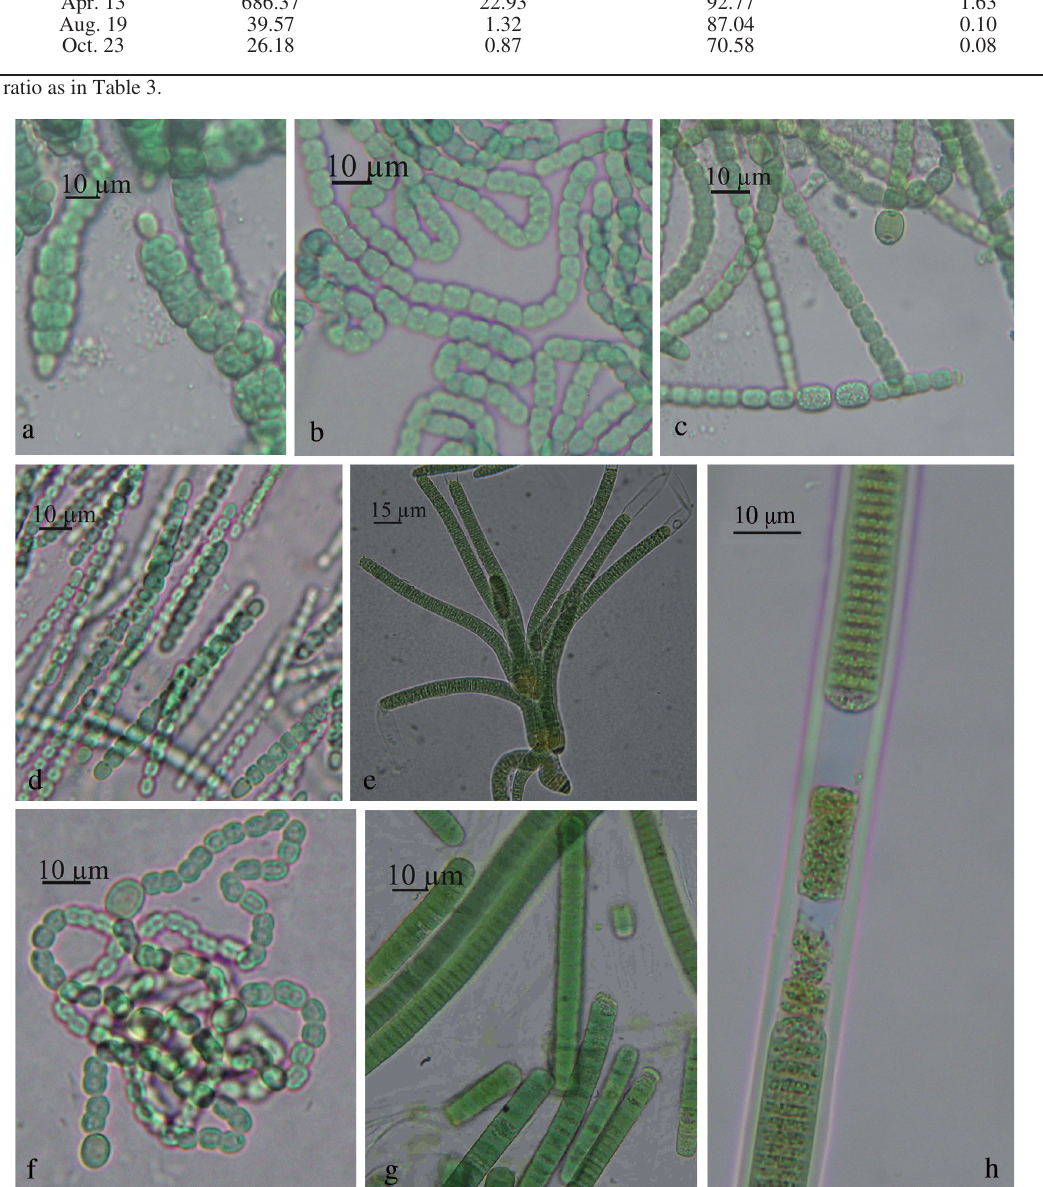
Fig . 4. – Photomicrographs of the main benthic nitrogen-fixing cyanobacteria detected in intertidal communities of sanya Bay, south China sea. (a, Anabaena sp. strain MCT2; b, Anabaena sp. strain MCT4; c, Anabaena sp. strain MCT5; d, Anabaena sp. strain MCT17; e, Calothrix sp. strain MCT1; f, Nostoc sp. strain MCT6; g, Oscillatoria sp. strain MCT7; h, Lyngbya sp. strain MCT6. d, f, isolated from RR communities; c, g, h, isolated from sM communities; a, b, e, isolated from MM